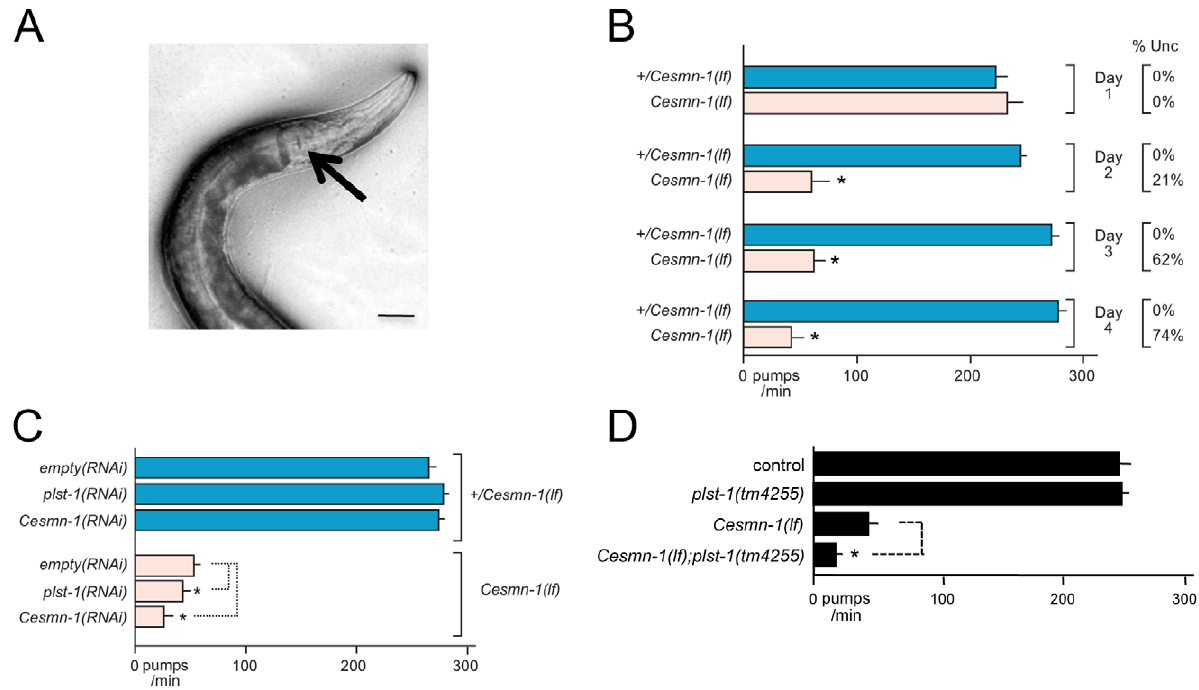
Figure 3. Loss of C.elegans PLS3 ortholog enhances the pharyngeal pumping defects of Cesmn-1(lf) animals. During feeding the C. elegans pharynx contracts at over 200 times per minute to capture and grind bacteria. A) Pharyngeal pumping rates can be determined by videotaping feeding and counting contractions as movement of the grinder (indicated by arrow) at slower playback speeds; scale bar indicates 40 microns. B) The progeny of hT2(lethal)[myo-2p::GFP]/Cesmn-1(lf) ( + /Cesmn-1(lf) ) animals were allowed to hatch on bacterial strains on standard C. elegans plates. Pumping rates of + /Cesmn-1(lf) heterozygous and Cesmn-1(lf) homozygous animals were determined on different days (day 1–4) on a control ‘empty vector’ bacterial strain. Decreased locomotion (sinusoidal movement) was also scored as uncoordinated (Unc). At day 1, the pumping rates and locomotion of Cesmn-1(lf) animals are identical to + /Cesmn-1(lf) or wild type animals. By day 2, the average pumping rates dropped dramatically (as previously reported [44]) and roughly 20% of animals were uncoordinated (column on right). By day 3 and 4, the pumping rates and locomotion of the majority of surviving animals are defective. Expressing Cesmn-1 in neurons is sufficient to restore pumping rates to near normal levels [44]. The behavior of Cesmn-1(lf) animals is initially normal due to maternal loading of Cesmn-1 gene products, but as the maternal contribution is depleted, loss of Cesmn-1 causes progressive defects in neuromuscular function. C) Pumping rates of + /Cesmn-1(lf) and Cesmn-1(lf) animals were determined at 3 days post-hatching on bacterial feeding strains expressing dsRNA corresponding to Cesmn-1 and plst-1 genes; ‘empty vector’ bacterial cultures were used as a control (‘empty’). plst-1(RNAi ) or Cesmn-1(RNAi) significantly descreased Cesmn-1(lf) pumping rates, but not + /Cesmn- 1(lf) pharyngeal pumps. D) Decreasing plst-1 function has no effect on pumping rates in heterozygous + /Cesmn-1(lf) animals, but pumping rates were significantly decreased in Cesmn-1(lf); plst-1(tm4255) double mutant animals. At least 20 animals were scored for each genotype in at least 2 independent trials. Pumping rates reported are the average of all animals in all trials. Because of the known impact of chromosomal pairing on histone methylation and gene expression [96], all animals tested herein were the progeny of animals carrying the hT2 balancer chromosome that prevents recombination. S.E.M. is reported. Significance of p # 0.05 is indicated with an asterisk and was determined using either an unpaired two- sample t -test or a Mann-Whitney U two-tailed test according to sample-specific parameters [100].